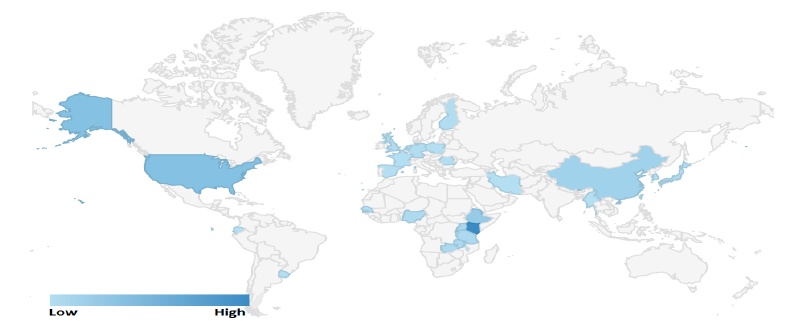
Figure 5. Data warehouse—distribution of users globally.